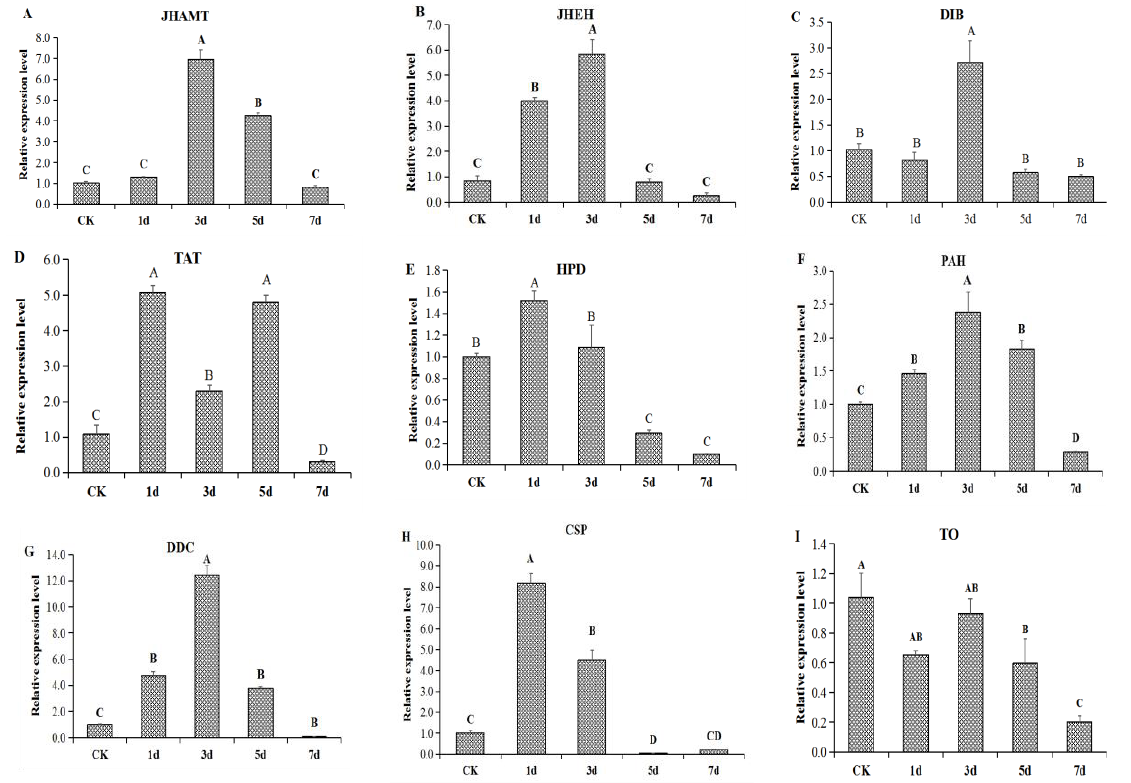
Figure 7. Effect of high-density stress on the expression of selected DEGs at different stages of phenotypic change in O. asiaticus . Different letters above the columns indicate significant differences at different time points ( p < 0.05; Tukey’s HSD test), and data are presented as means ± SD ( n = 4). JHAMT ( A ), JHEH ( B ), DIB ( C ), HPD ( D ), TAT ( E ), PAH ( F ), DDC ( G ), CSP ( H ), and TO ( I ) .